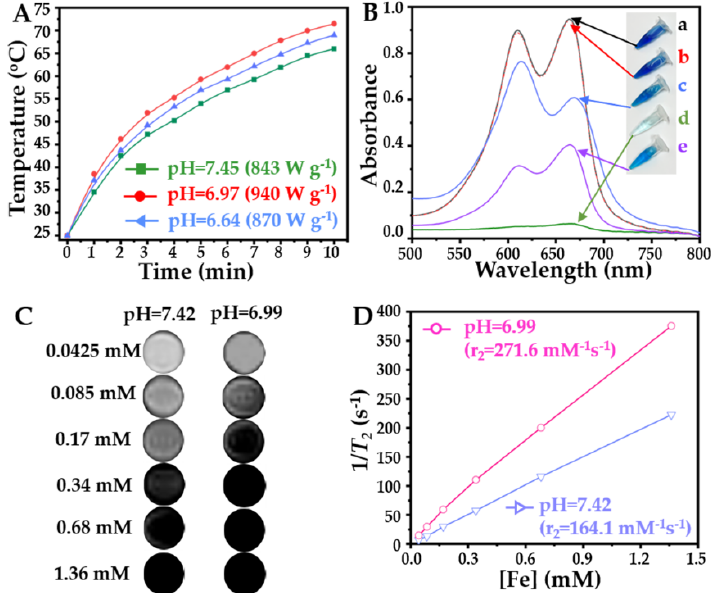
Figure 6. The effect of the tumor microenvironmental pH value on the tumor microenvironment- responsive MNF’s applications, including ( A ) enhanced MH with a concentration of Fe at 100 μ g mL − 1 ; ( B ) increased ROS generation with the concentration of the MNF at 250 μ g mL − 1 ; ( C , D ) improved T 2 relaxivity of the MRI with varied Fe concentrations from 1.36 to 0.0425 mM. Under the same concentration of Fe (100 μ g mL − 1 ), the MNF could increase the sur-